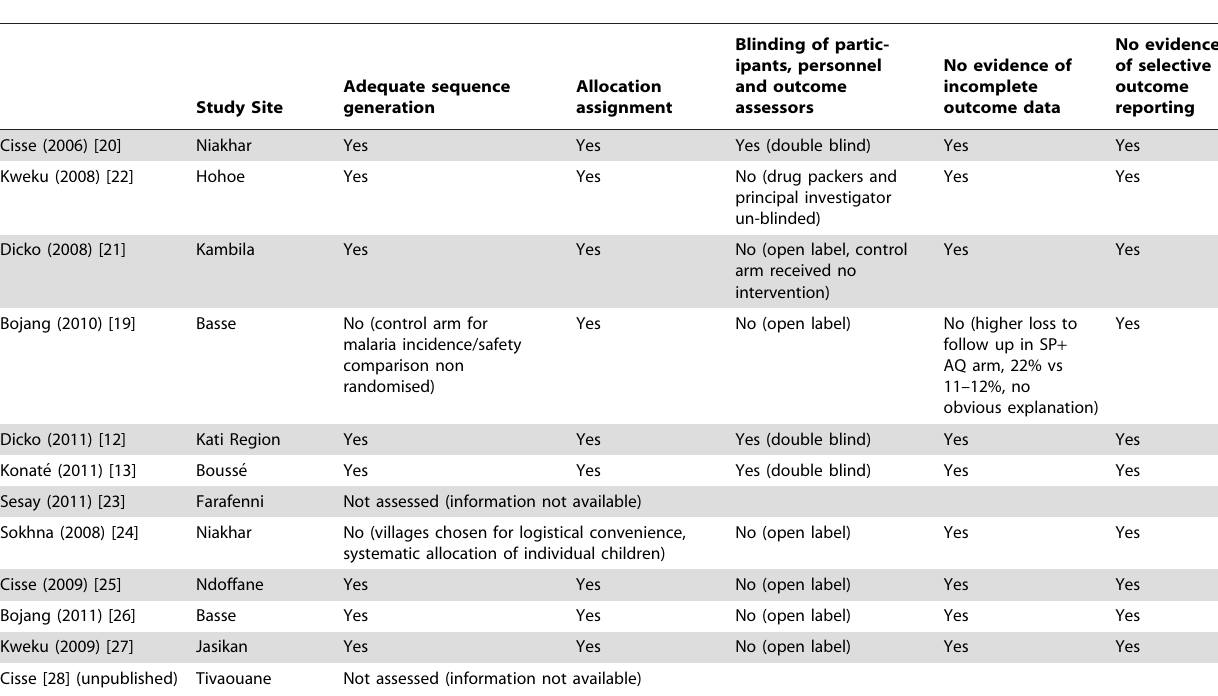
Table 3. Assessment of risk of bias in